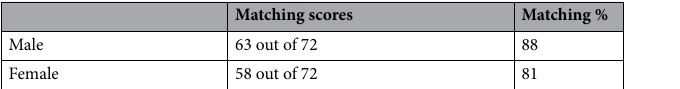
Table 7. Matching scores and percentages between MDP and real life doctors’ prescriptions.